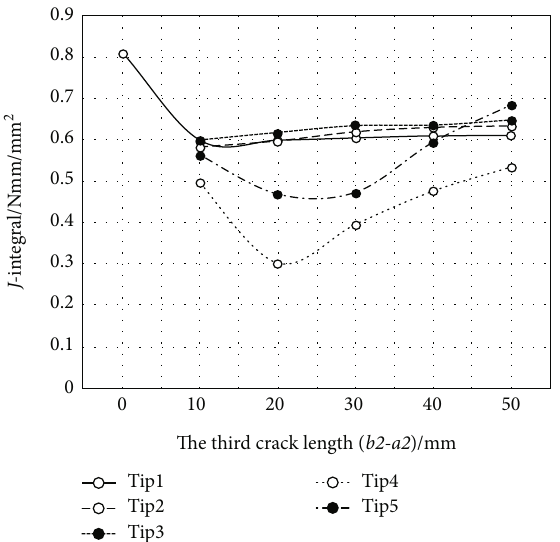
Figure 6: The J -integral variation with third crack of three collinear cracks.